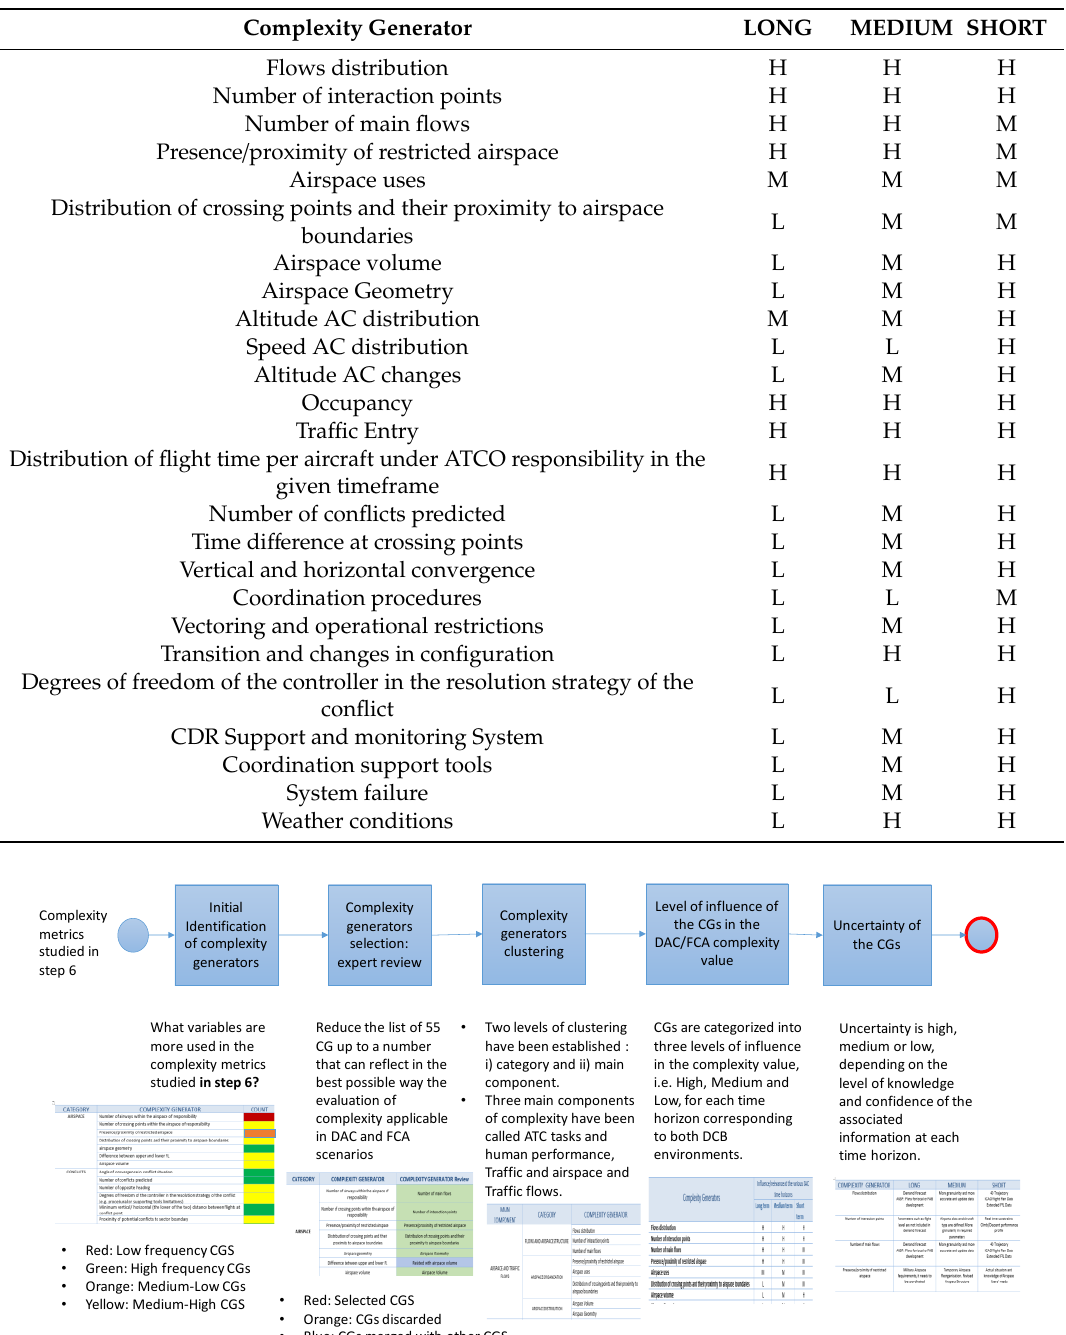
Table 4. CGs influence for DAC at each time horizon.